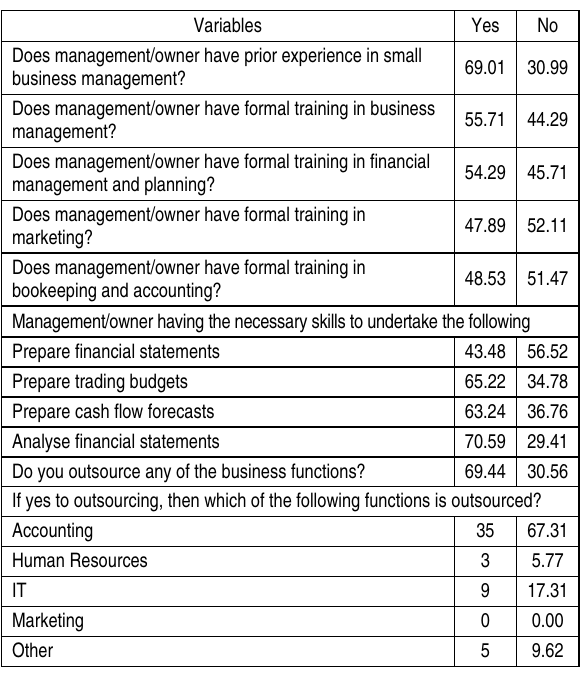
Table 4 (cont.). Summary of managerial skills of